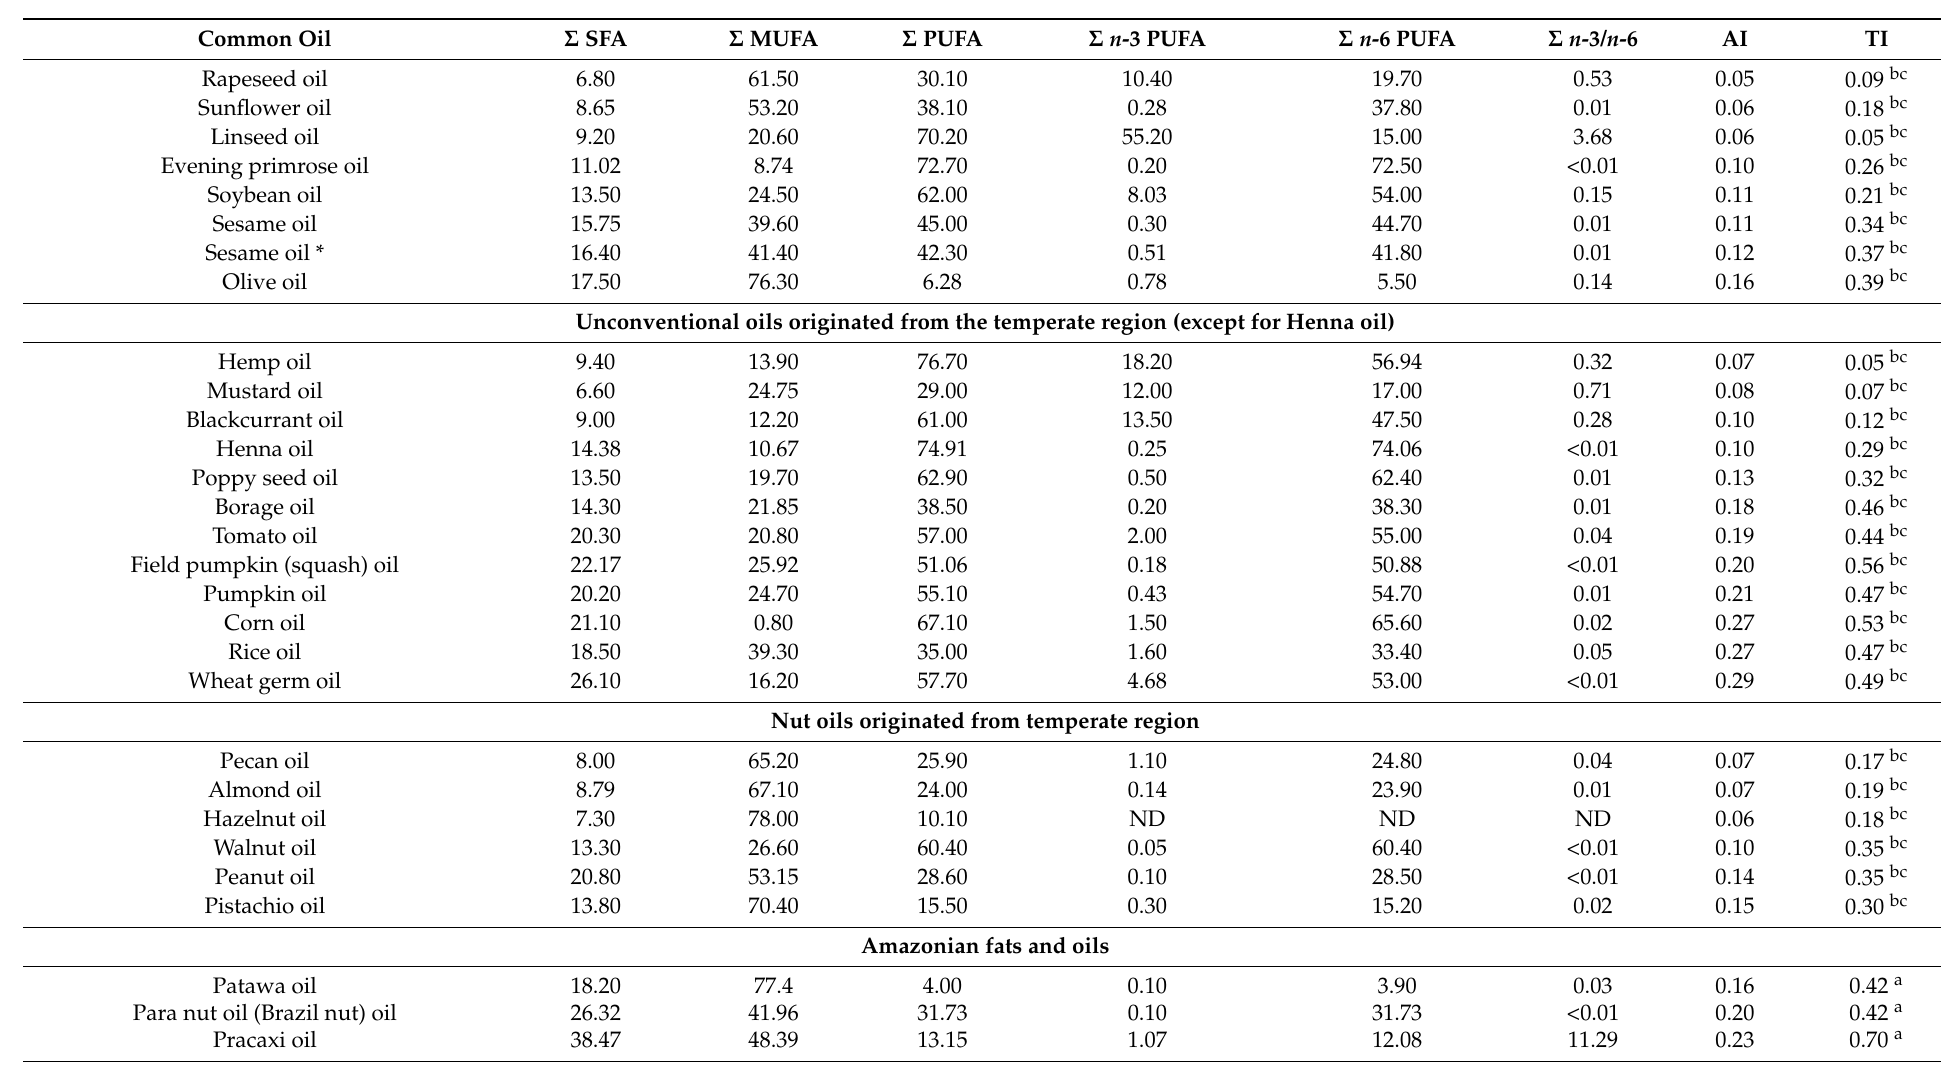
Table 1. Sum of fatty acids in different types of oils, and the calculated values of atherogenic and thrombogenic